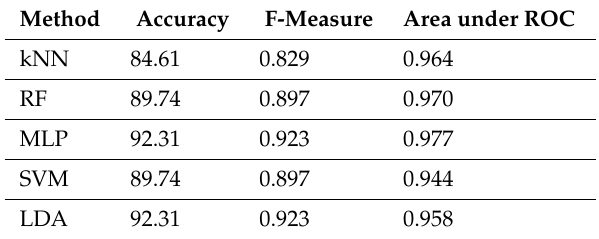
Table 5. Results obtained by applying different classifiers to extracted features by using deep transfer learning. Results obtained with applying DTL from the local CNN architecture are shown.